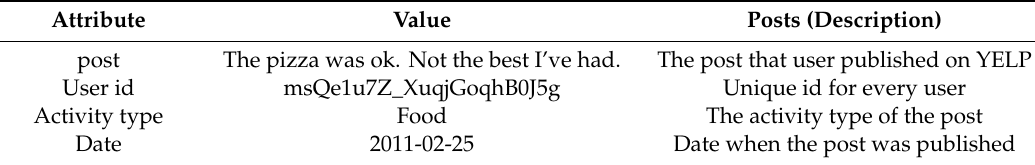
Table 1. Example of an item in the dataset, which consists of the post text, user id, and activity type. Attribute Value Posts (Description) post The pizza was ok. Not the best I’ve had.